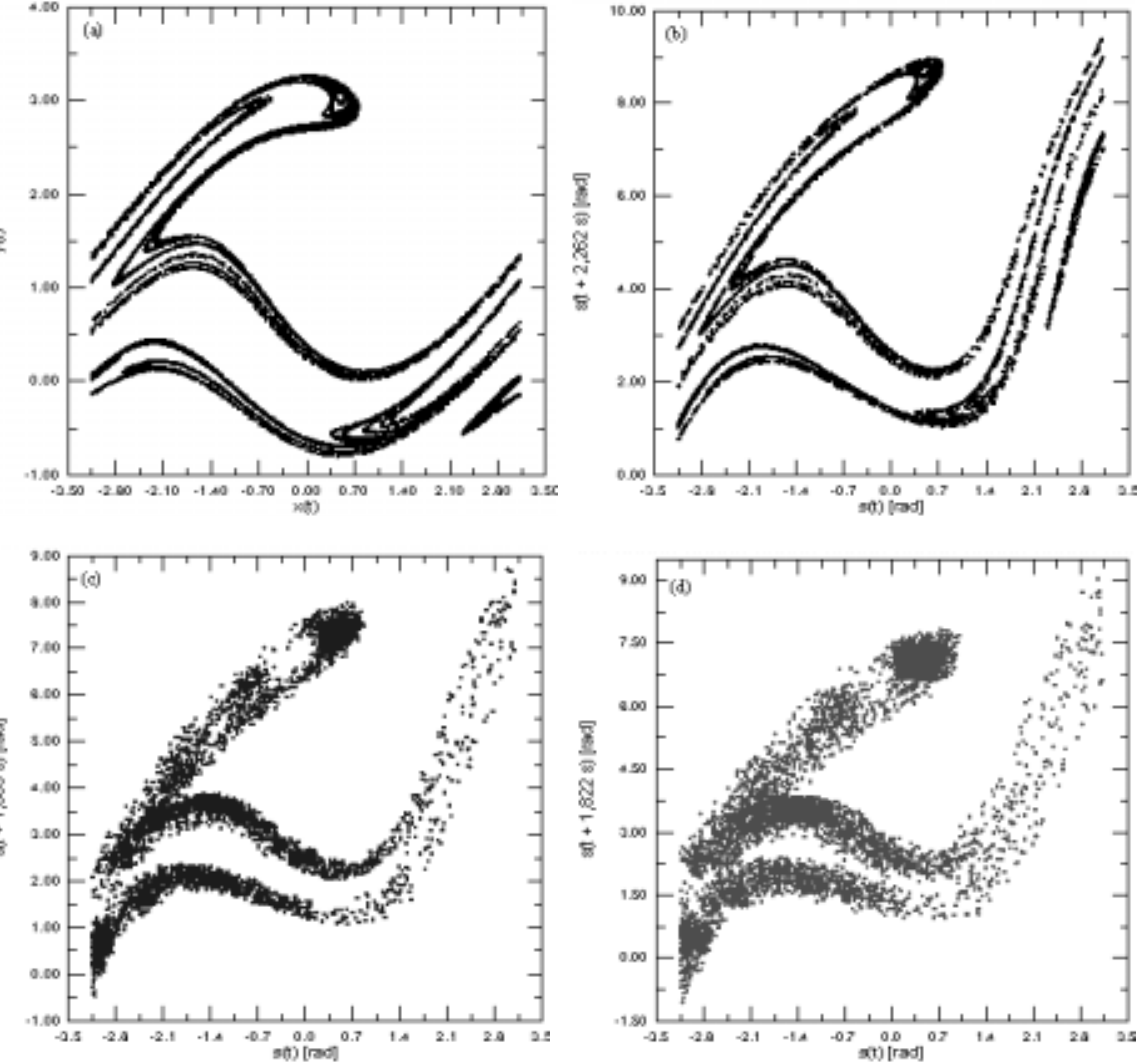
Fig. 6. Strange attractors. (a) Numerical; (b) Reconstructed, A = 0; (c) Reconstructed, A = 0.314; (d) Reconstructed, A =